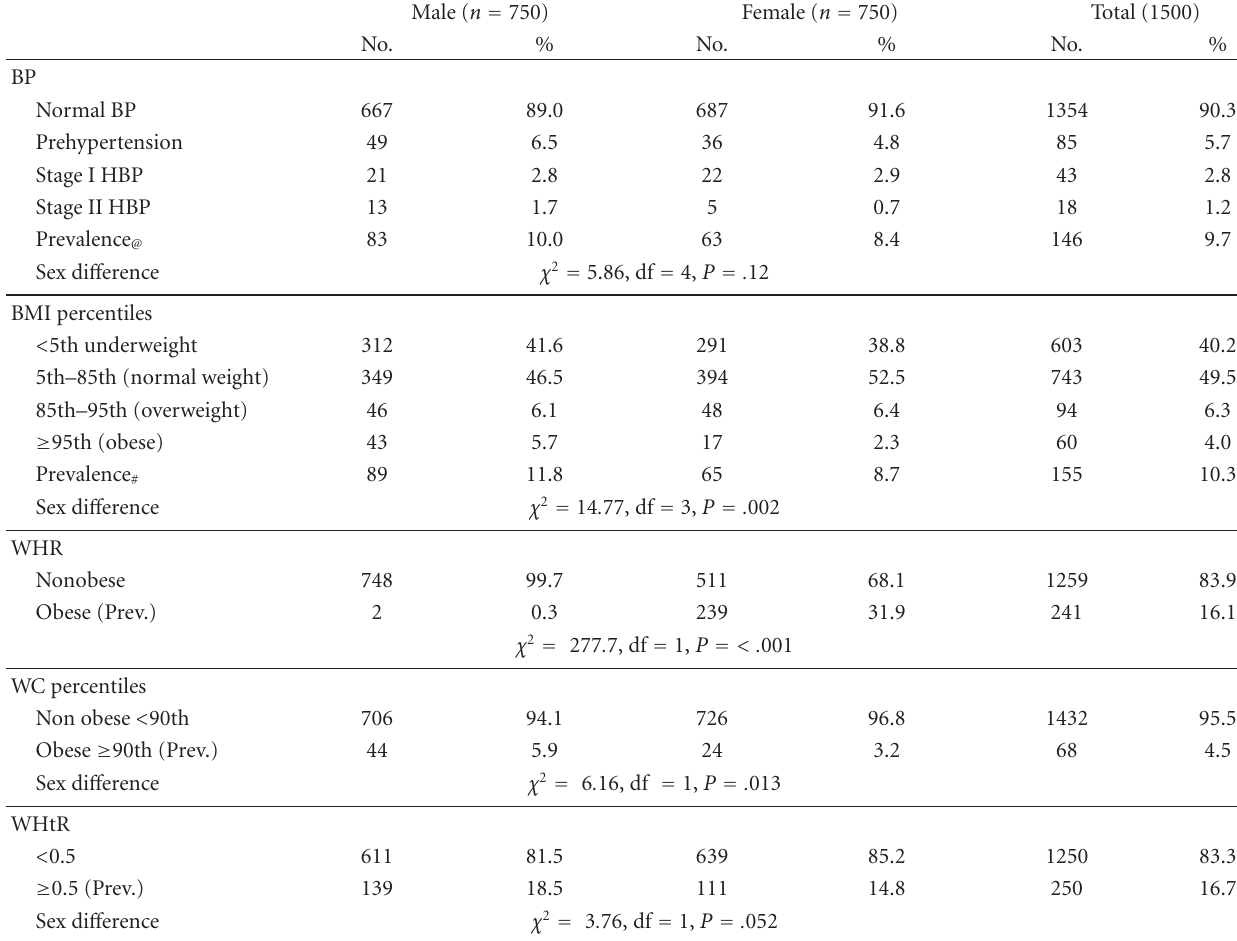
Table 1: Distribution of the study sample of school adolescents according to patterns of blood pressure and body composition by